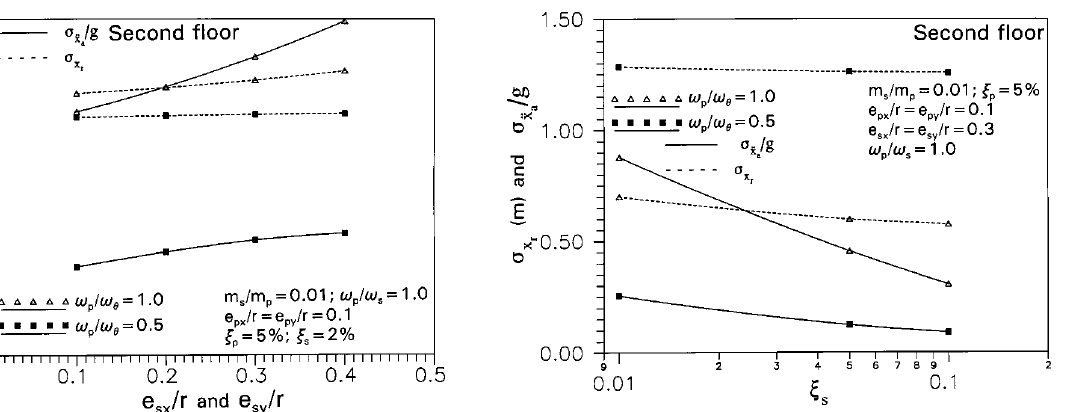
Fig. 18. Variation of (cid:27) x level, for ! p =! s = 1.0; ! p =! (cid:18) = 1.0 and 0.5; (cid:24) p = 5%